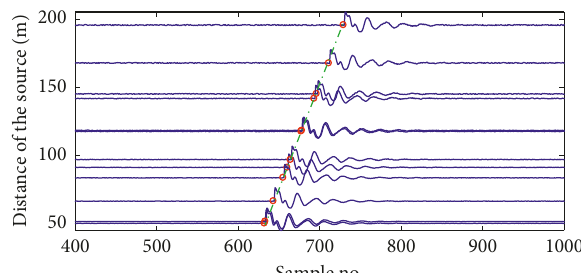
Figure 6: Picking results of all receivers showed in the time-dis- tance